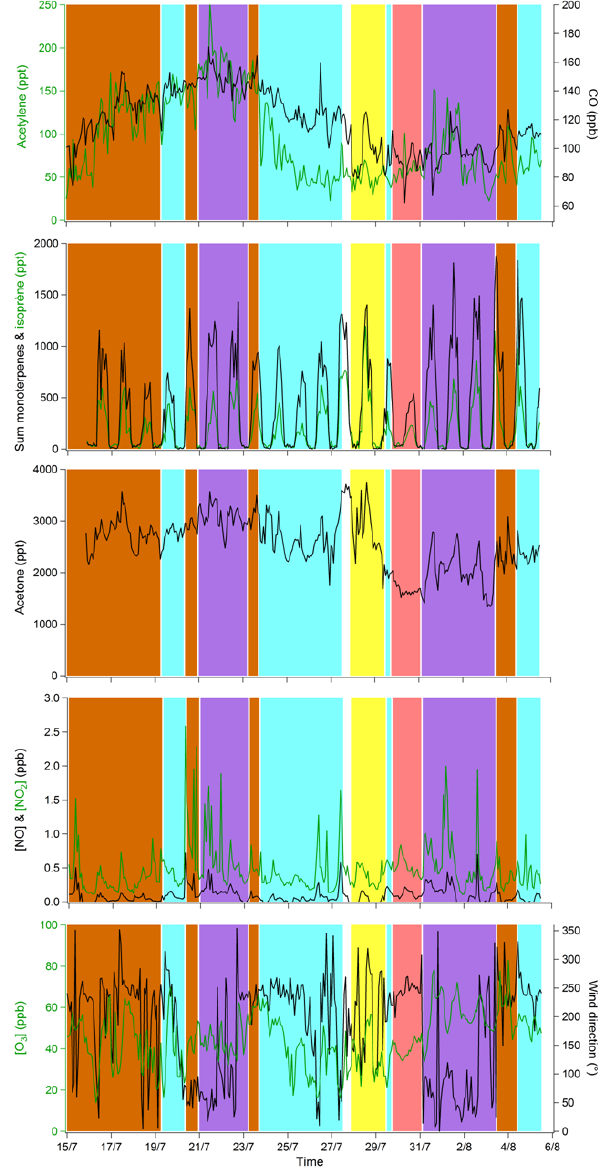
Figure 4. Time series of selected trace gases and wind direction at Cape Corse during the ChArMEx SOP2 field campaign. The col- ored areas correspond to back-trajectory clusters (light blue, purple, yellow, pink and orange-brown for the marine west, Europe north- east, Corsica south, France northwest and calm low wind clusters,